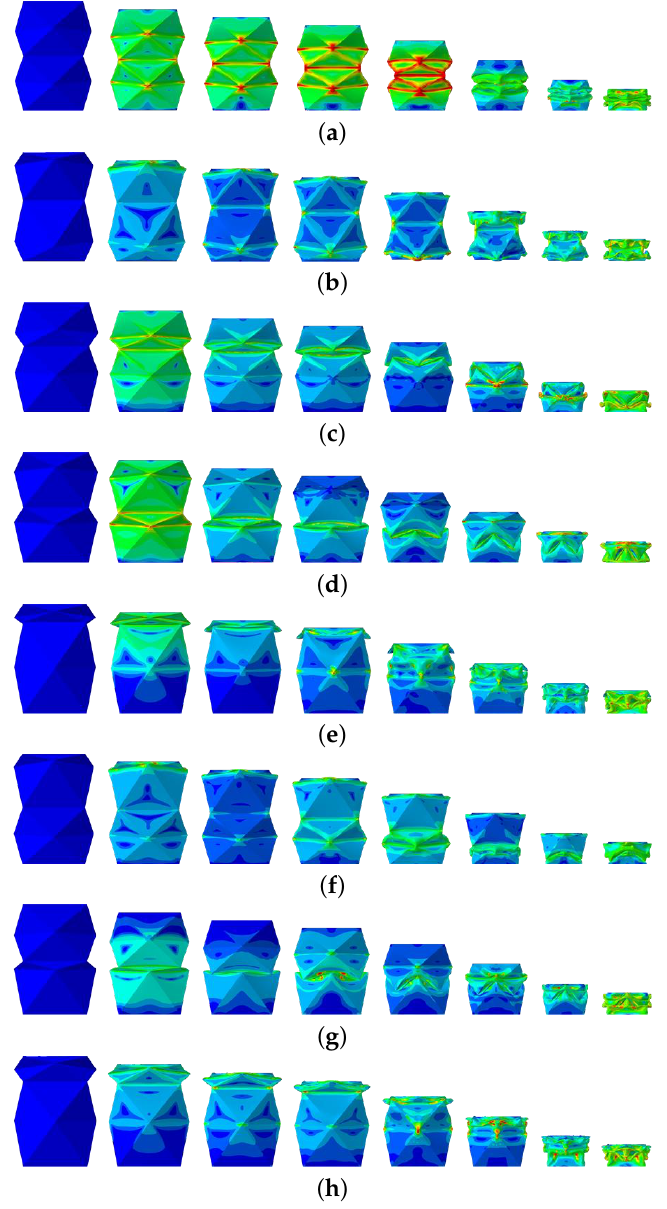
Figure 12. Stress cloud diagram of compression crushing process of typical tubes: ( a ) D2-1; ( b ) D2- 10; ( c ) D2-9; ( d ) D2-2; ( e ) D2-12; ( f ) D2-29; ( g ) D2-28; ( h ) D2-16. The corresponding crushing displace- ments: 5 mm; 10 mm; 15 mm; 25 mm; 40 mm; 55